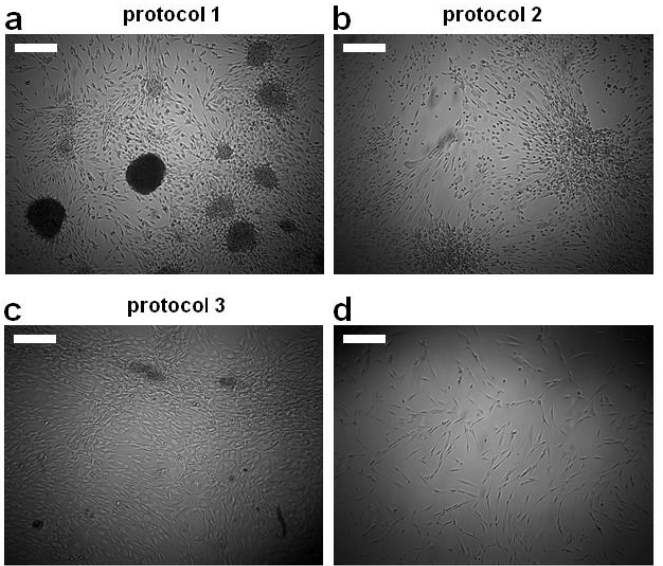
Figure 1. Using different glial differentiation protocols, ASCs can be differentiated into different phenotypes. ( a ) Morphological appearance of cells differentiated with protocol 1. ( b ) Morphological appearance of cells differentiated with protocol 2. ( c ) Morphological appearance of cells differentiated with protocol 3. ( d ) Morphological appearance of undifferentiated cells. Scale bars are 300 µ m.